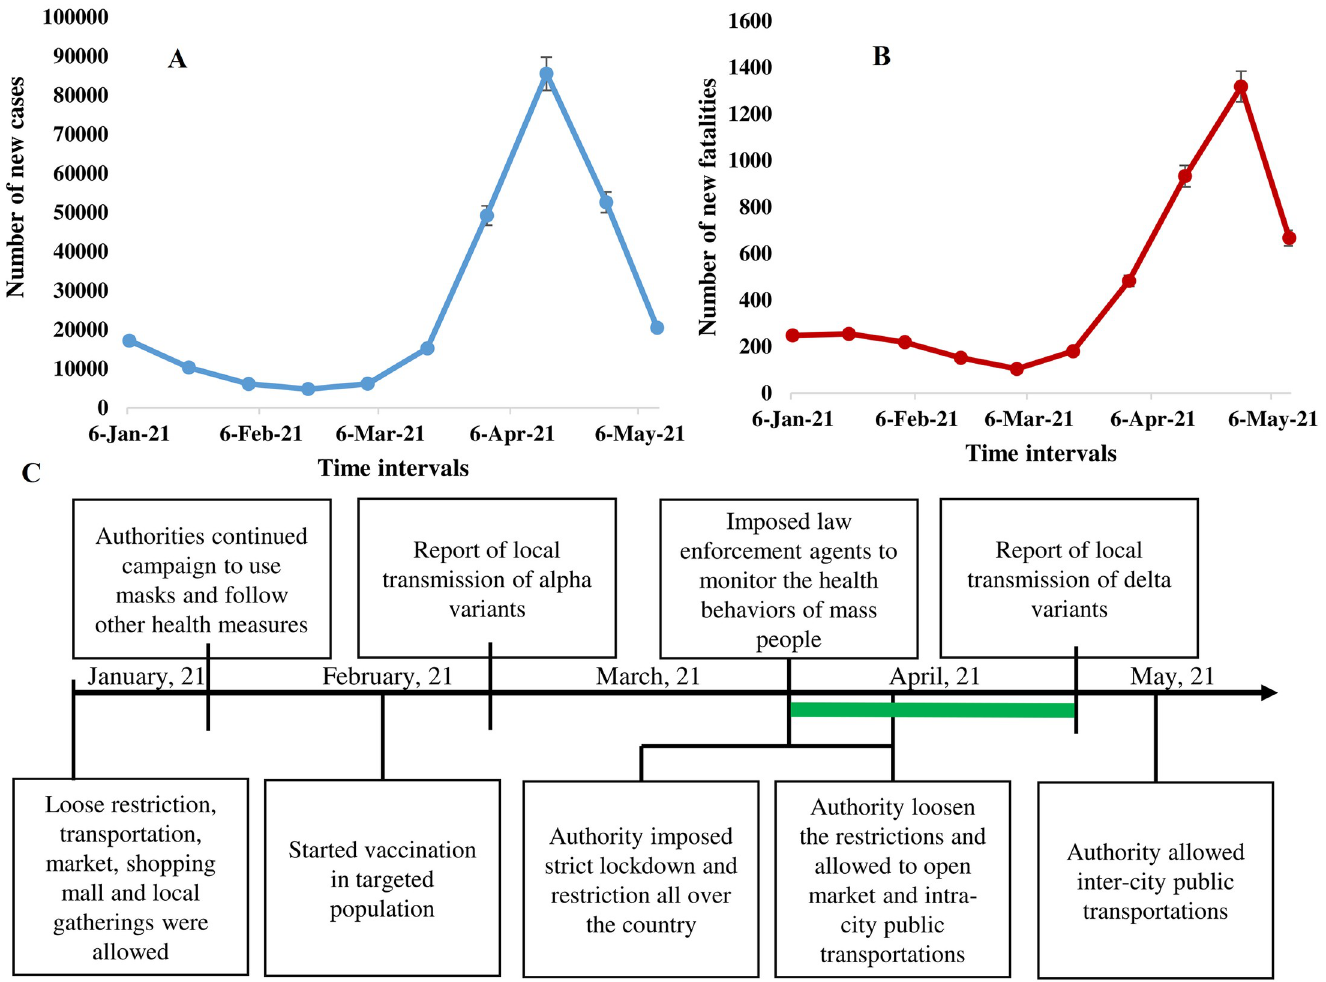
Fig 3. Distribution of COVID-19 A. Cases and B. Fatalities in Bangladesh during the second wave, C. Chronology of taken measures by the authorities against COVID-19 during the second wave.